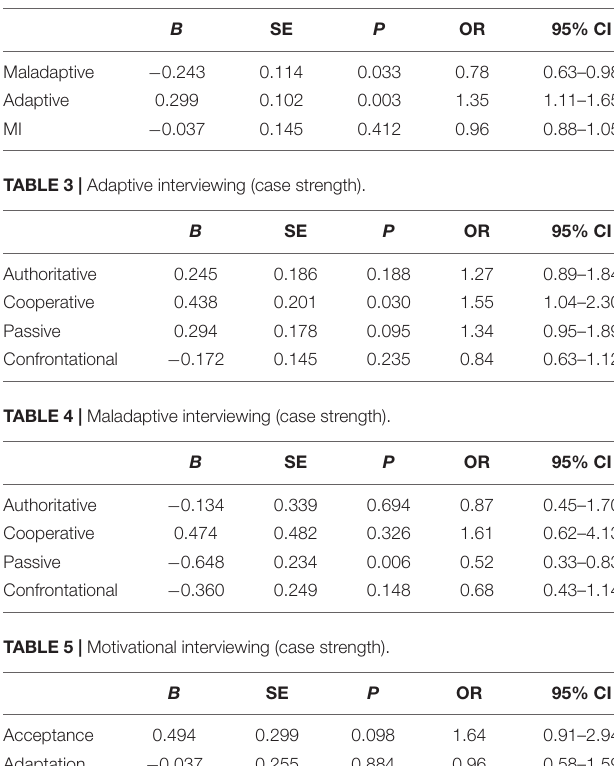
TABLE 2 | Adaptive, maladaptive, and MI (case strength).